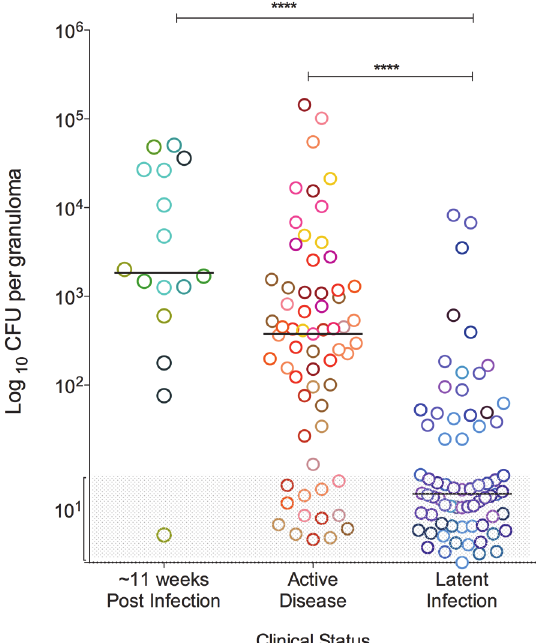
Figure 1. Bacterial burden of individual granulomas. Bacterial burden is represented as the colony forming units (CFU) in logarithmic scale, per granuloma. Greyed area represents sterile granulomas (indicated as log 10 1), which were assigned arbitrary range of values so that all granulomas can be seen in the graph. Each symbol represents a granuloma and a color represents granulomas from one animal. Granulomas are grouped as per the clinical status of the animal, where those animals that were infected for * 11 weeks are in shades of green, active disease in shades of warm colors and latent infection in shades of cool colors. ( **** : p < 0.0001, Dunn ’ s multiple test